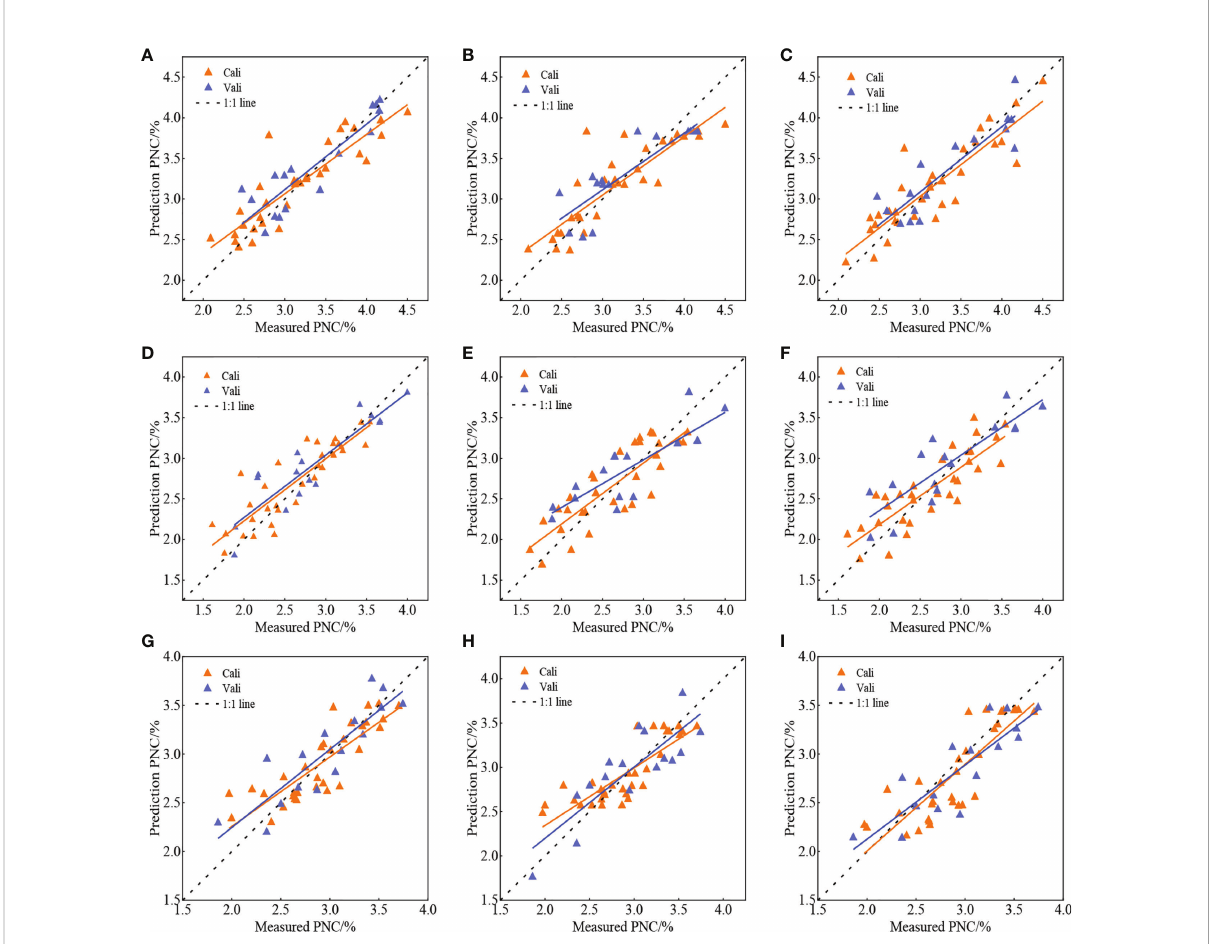
FIGURE 8 Validation effect of estimation of potato PNC based on fusion characteristics at each growth stage. (A, D, G) MLR, S1-S3; (B, E, H) RF, S1-S3; (C, F, I) KNN,